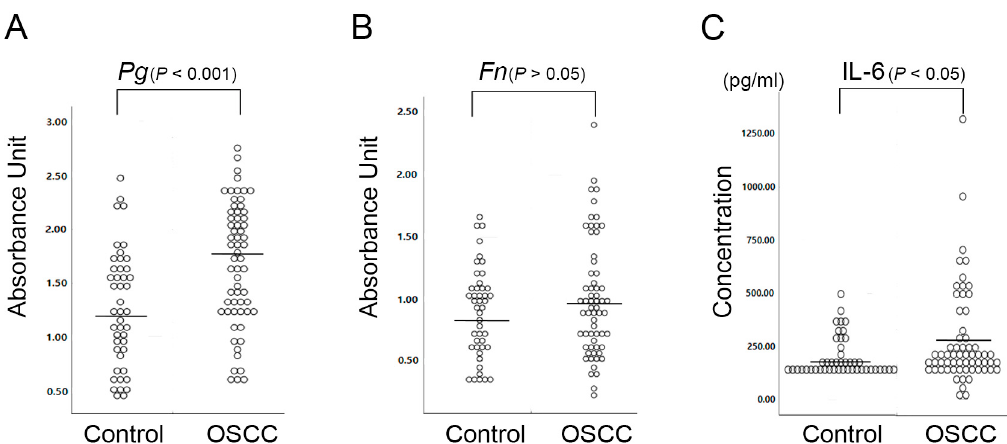
Figure 1. Serum antibodies against P. gingivalis and F. nucleatum and serum IL-6 levels in OSCC patients were compared with those in healthy controls using an enzyme-linked immunosorbent assay (ELISA). The serum levels in healthy controls ( n = 46) and OSCC patients ( n = 62) were ( A ) P. gingivalis IgG, 1.25 ± 0.54 and 1.69 ± 0.57, ( B ) F. nucleatum IgG, 0.88 ± 0.36 and 1.00 ± 0.46, ( C ) IL-6, 199.51 ± 89.38 (pg / mL) and 274.93 ± 228.57 (pg / mL), respectively.